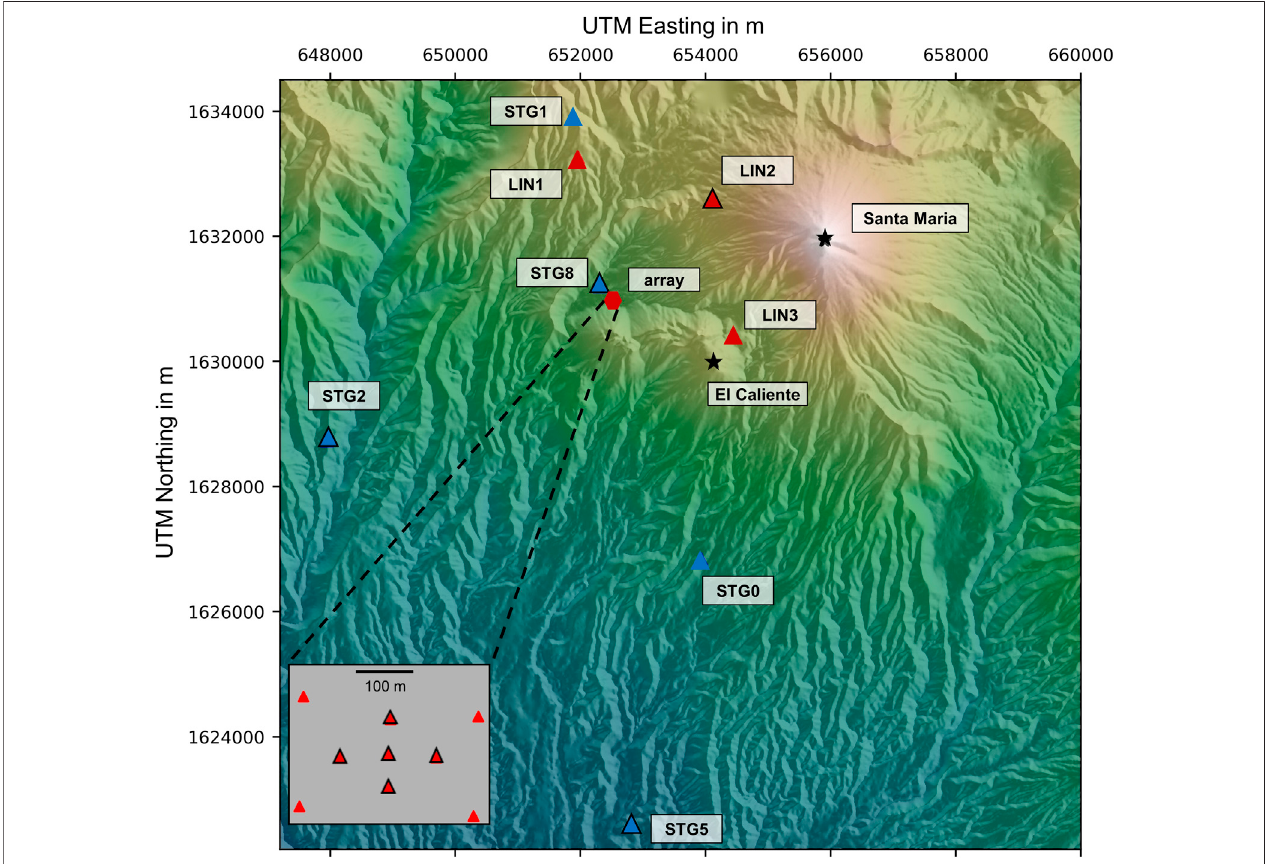
FIGURE 2 | Station distribution during the fi eld measurements in January 2019. Blue triangles mark the stations of the permanent network of ULIV (University of Liverpool) and KIT (Karlsruhe Institute of Technology), and red triangles are stations installed temporarily. Black contour lines around the triangles indicate the additional installation of an infrasound sensor. The red hexagon marks the position of the seismo-acoustic array (also inset, lower left). The thermal camera was installed at station STG5. The peaks of Santa Maria and El Caliente are marked with black stars.